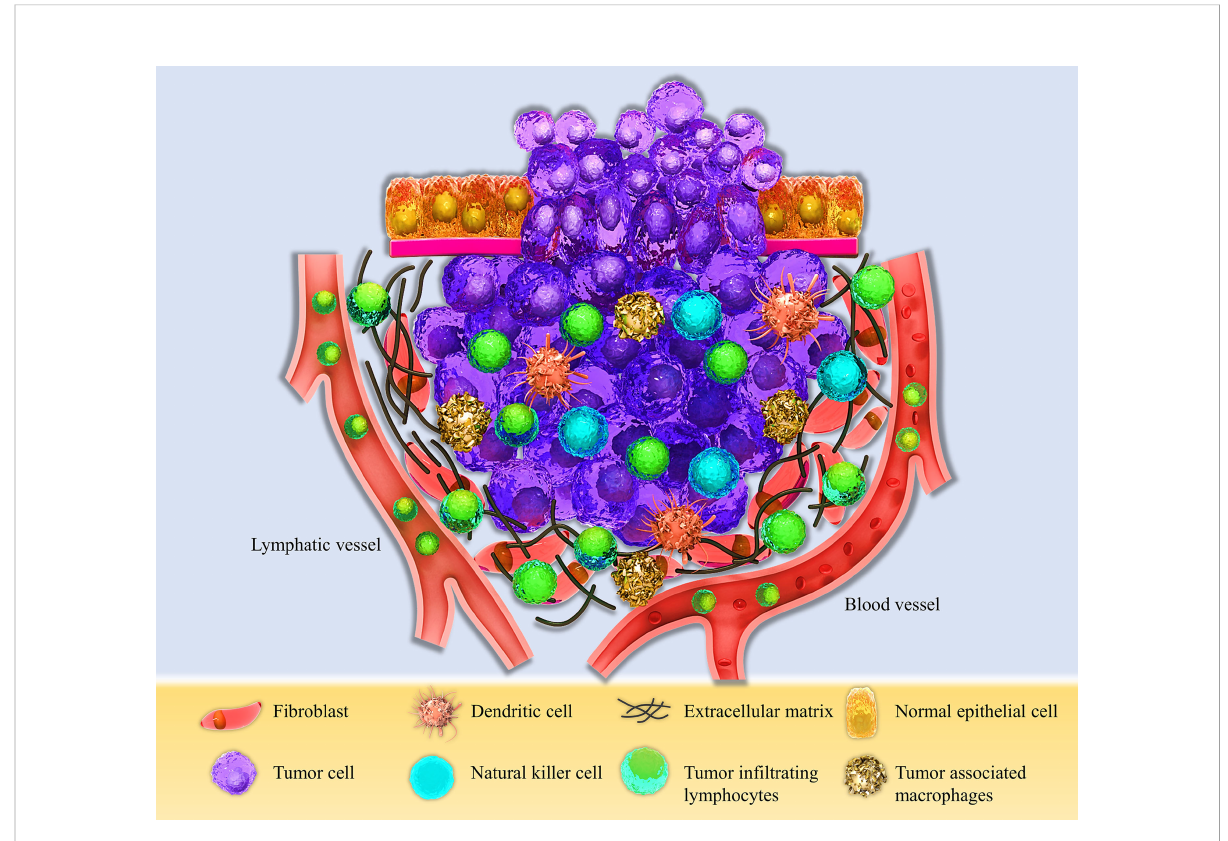
FIGURE 1 Schematic view of the Tumor microenvironment (TME). The TME consists of different compartments, including the proliferating tumor cells, tumor site, and tumor-in fi ltrating immune cells, such as Dendritic cells (DCs), Natural killer cells (NK cells), Tumor-associated macrophages (TAMs), and Tumor-in fi ltrating lymphocytes (TILs), and the stromal part containing fi broblasts, extracellular matrix, and lymphatic and blood